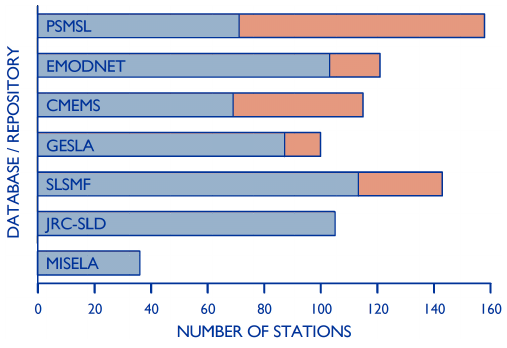
Figure 7. Number of tide gauge stations in the Mediterranean and Black Sea for which sea level data can be found in the quoted databases or data repositories. As of 15 November 2021, the sta- tions having no data since 2018 for the PSMSL, since 2021 for EMODnet and the Copernicus Marine Service and since 2020 for GESLA and being not operational in the preceding 7d for SLSMF and JRC-SLD are indicated in red. For MISELA, data are available up to 2019, at